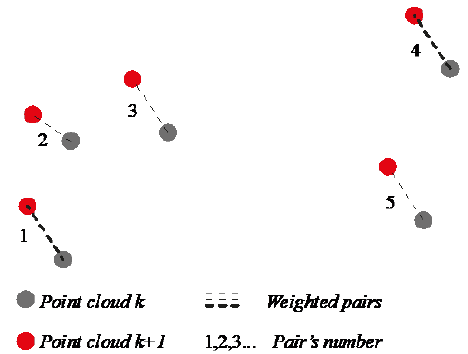
Figure 4. Weighting due to proposed error factor. Bolted, dashed line equals more weight for specific pair.